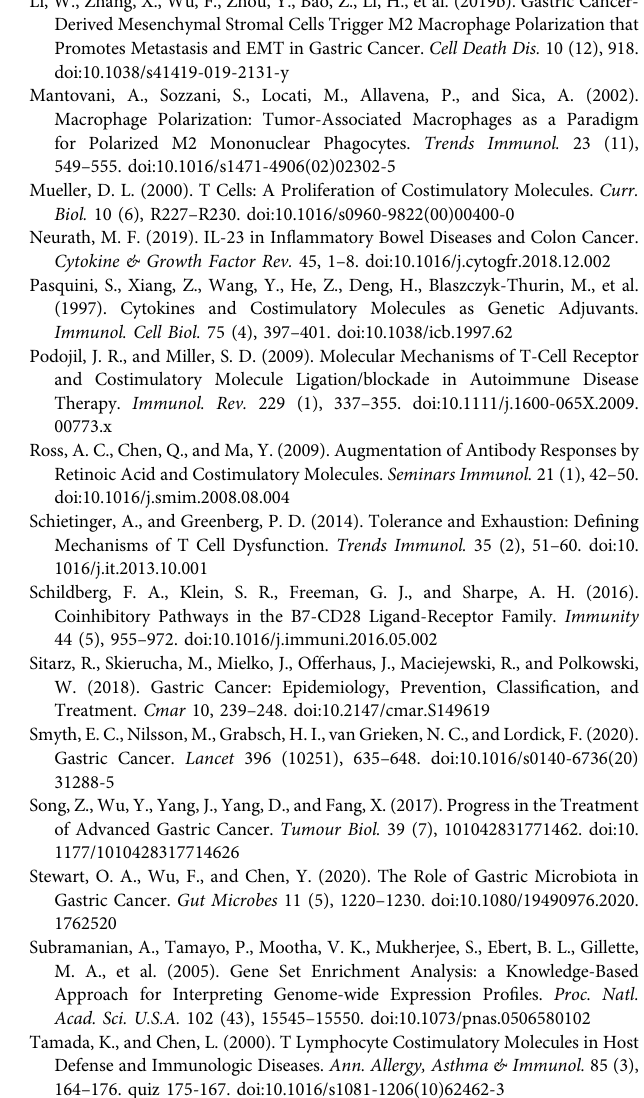
Supplementary Figure S1 | GSEA of high and low AP000695.2